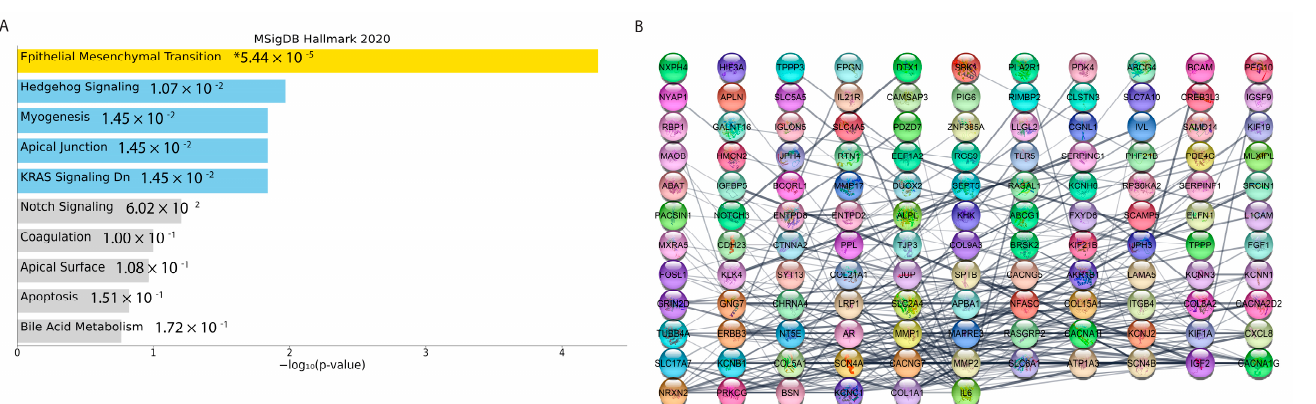
Figure 15. Sample dendrogram and trait heatmap. ( A ) The five traits are Tucidinostat, DL − sulforaphane, TP − 472, Control, and EMT. ( B ) Scale independence and mean connectivity of various soft-thresholding values. ( C ) Gene co-expression network modules. Different colors represent different modules, and gray represents genes that cannot be merged into any module. The bottom colors represent the module after merging modules. ( D ) Heatmap of the correlation between the clinical traits and MEs. Each cell contains the corresponding correlation and the P value. The table is color-coded by the correlation according to the color legend. ( E ) Using linear regression, scatter plots of gene significance (GS) vs. module membership (MM) in the blue modules.